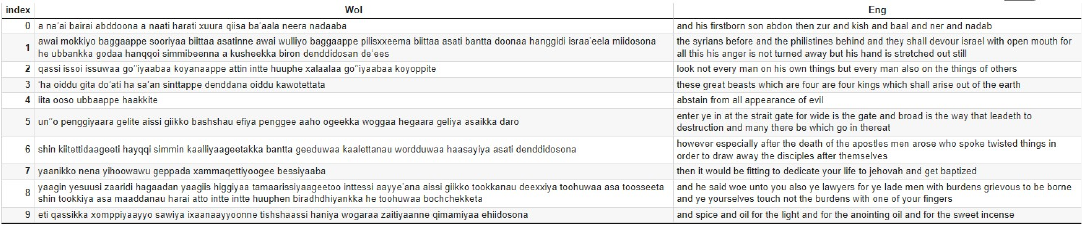
Figure 5. Sample texts from Wolaytta–English parallel dataset.